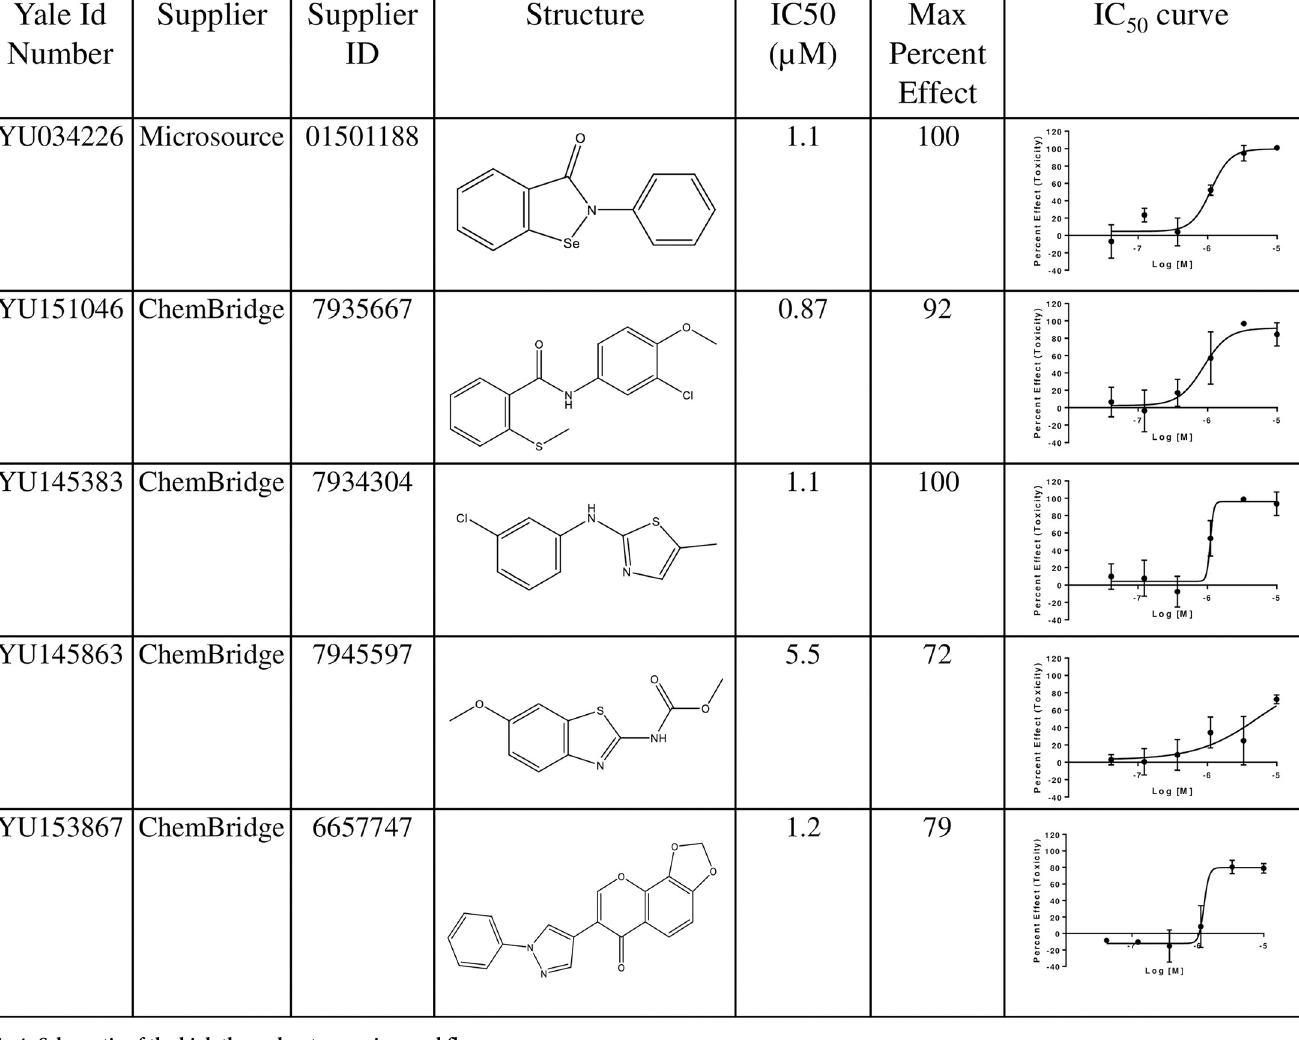
PLOS ONE | https://doi.org/10.1371/journal.pone.0217019 June 3,